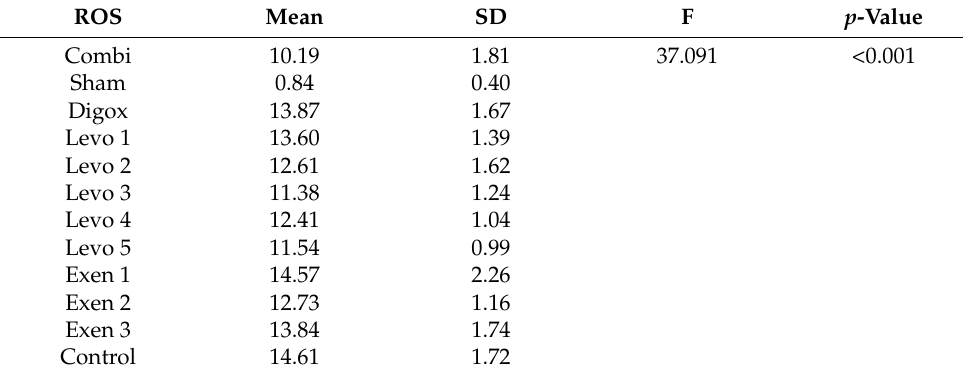
Table 18. Effect of group on Reactive Oxygen Species.